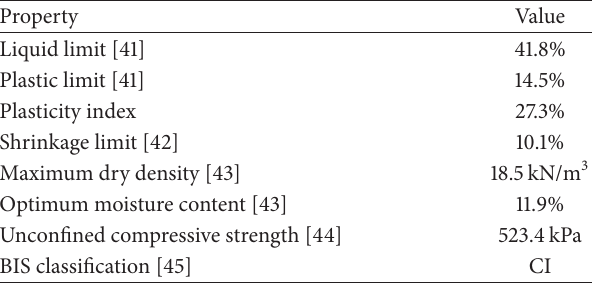
Figure 1: Steel moulds adopted for moulding of stabilized